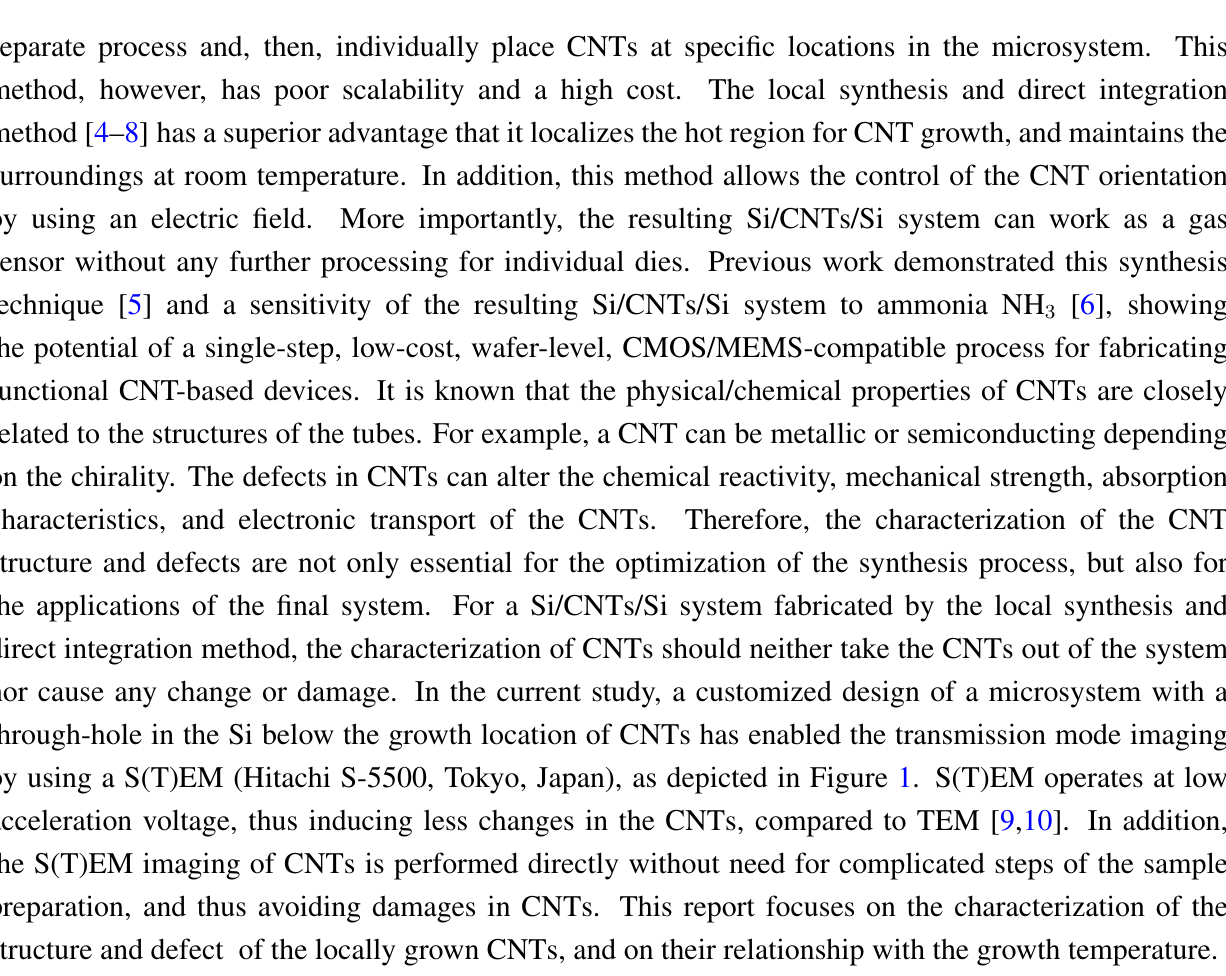
Figure 1. ( a ) An optical micrograph of a microsystem for locally synthesizing and